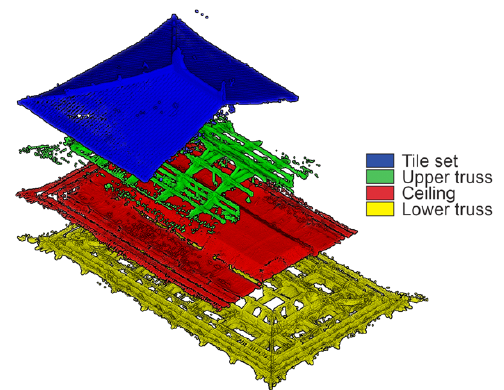
Figure 9. Classification result at level 2 on roof for FKS.